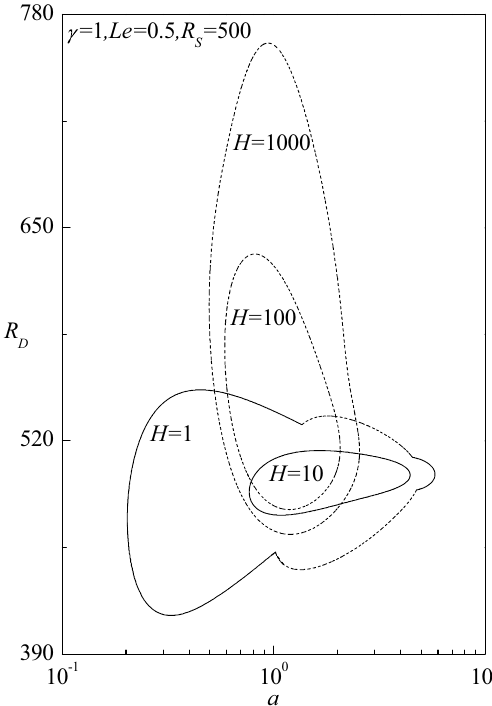
Figure 5. Evolution of neutral stability curves in the ( a , R D ) -plane for different values of H